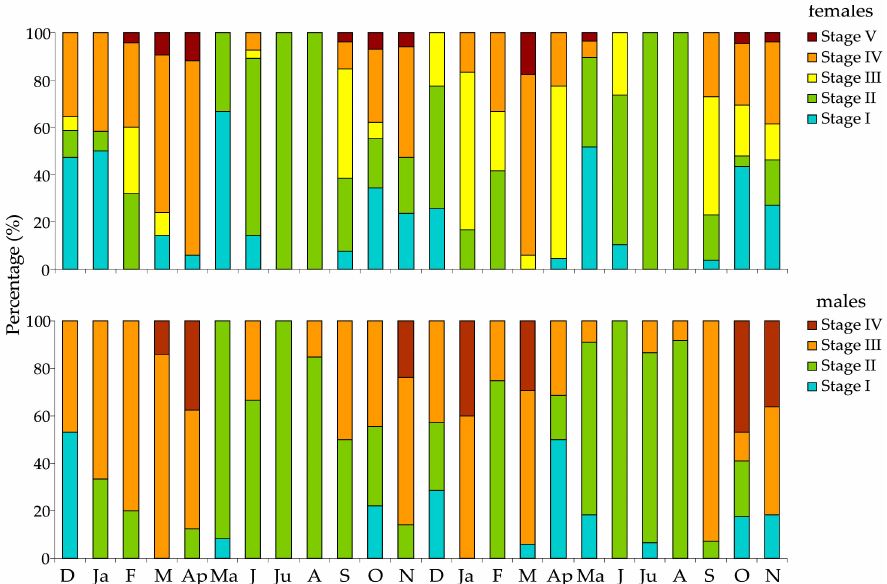
Figure 6. Relative frequency of gonad maturity stages of female and male Paracentrotus lividus individuals at the S2 station in the Pagasitikos Gulf, per month, from December 2008 to November 2010.